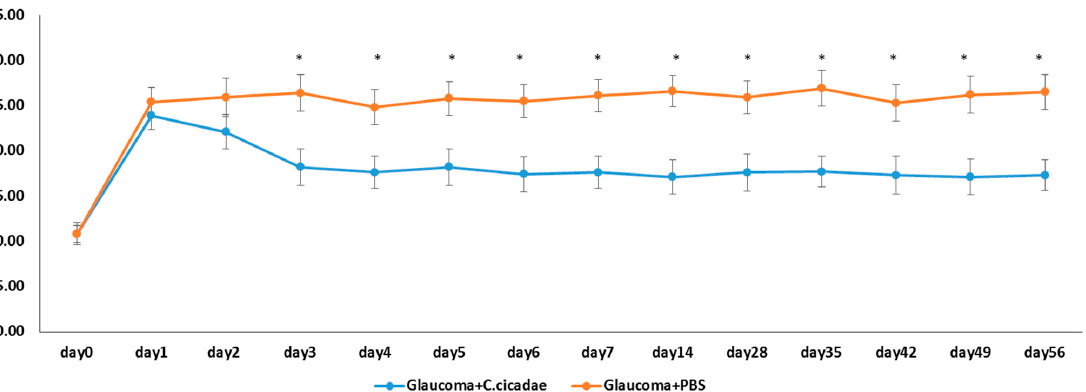
Figure 1. Effect of C. cicadae mycelia extract on IOP in the glaucoma model. *: p < 0.05, n = 12, mean ± SEM. versus Glaucoma+PBS group.